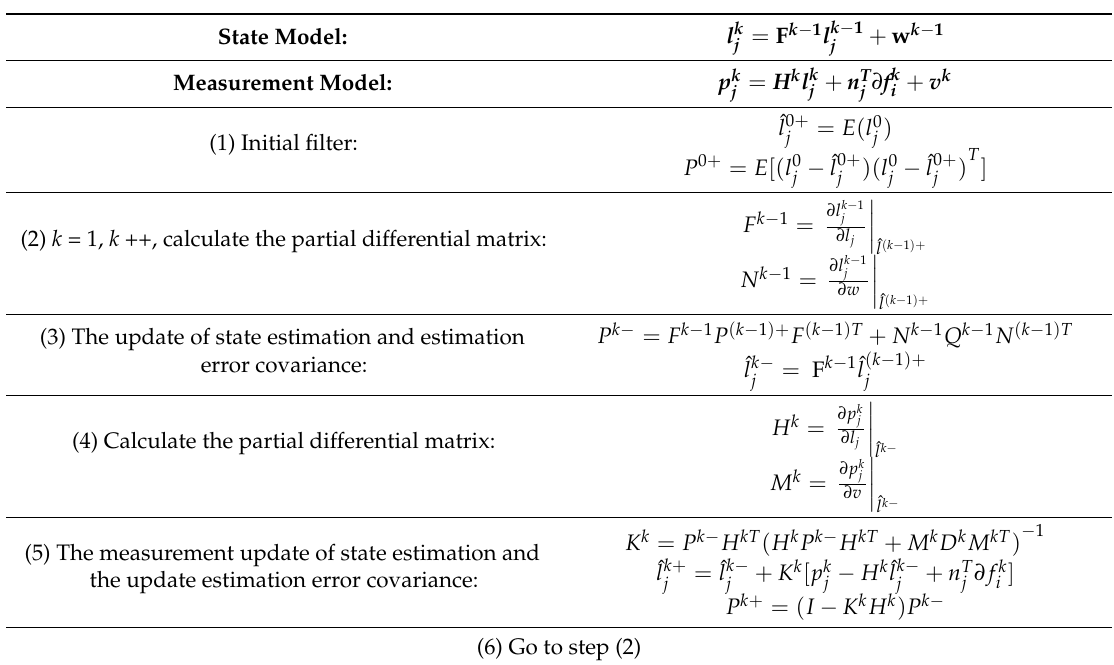
Table 2. A summary of the EKF